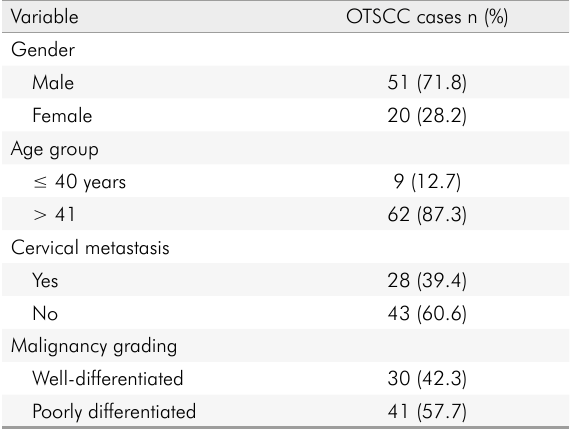
Table 1. Demographic and clinical characterization of the cases of oral tongue squamous cell carcinoma